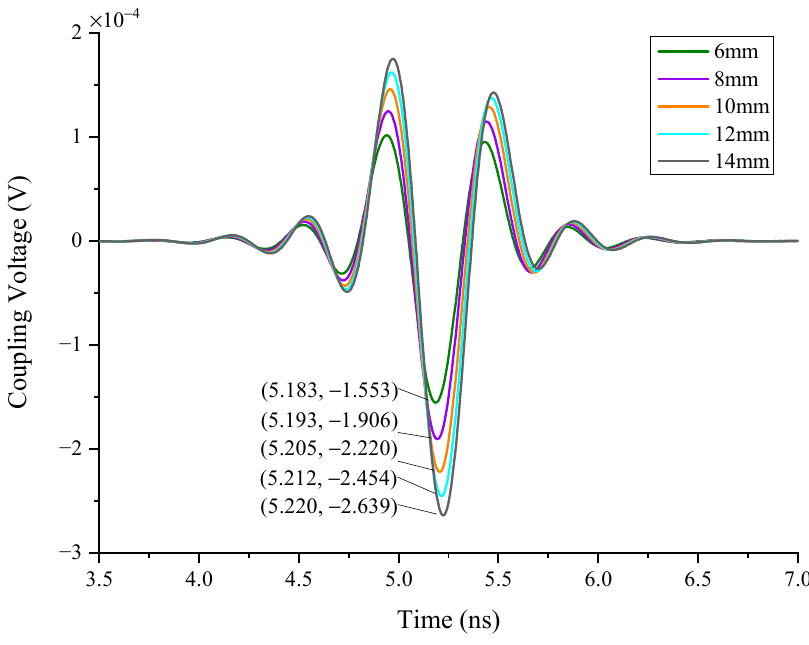
Figure 14. The responses of different lengths of single wire.